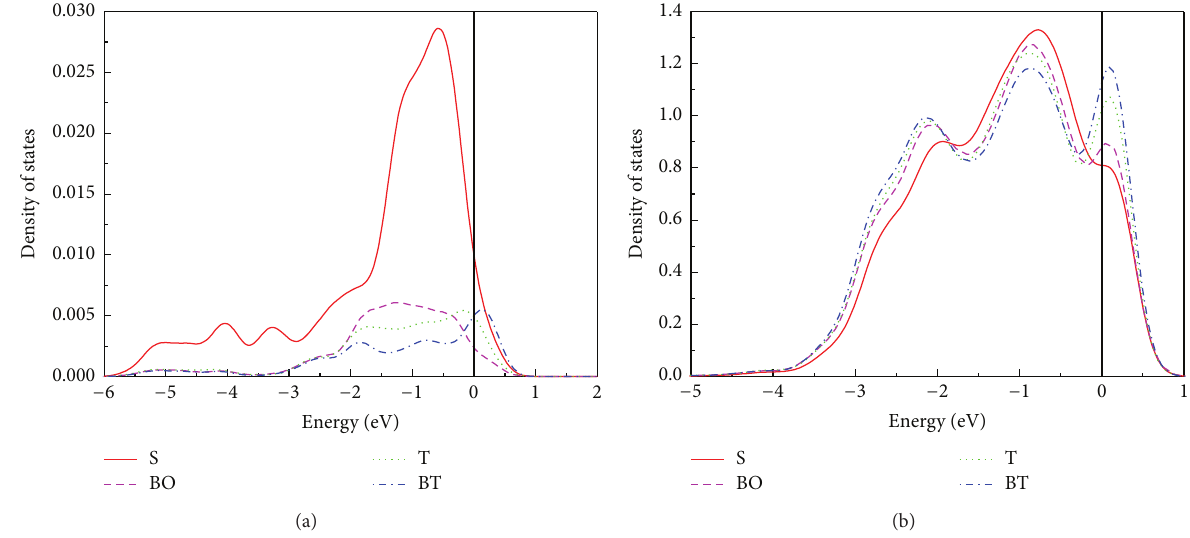
Figure 3: Local DOS of a He interstitial and its NN-Zr: (a) the s -projected DOS of He and (b) 𝑑 -projected DOS of NN-Zr for the He interstitials at various positions (vertical line is the Fermi level 𝐸 𝐹